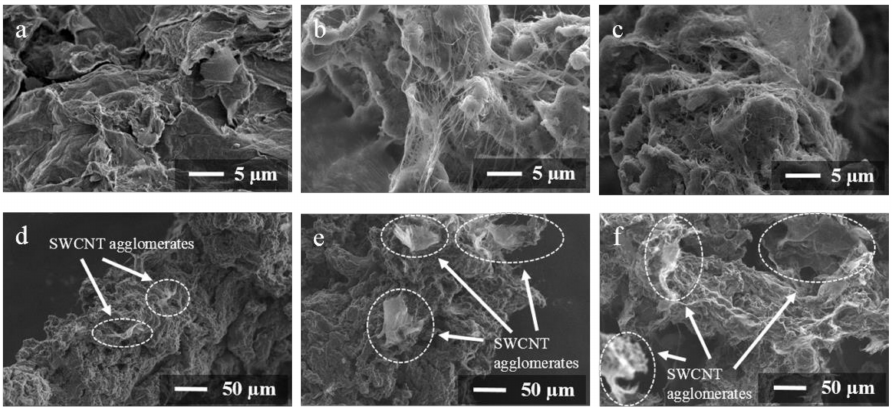
Figure 1. SEM images of the polymer powder particles coated with 1 wt% carbon nanomaterials: ( a ) 1FPC-0, ( b ) 1FPC-50 and ( c ) 1FPC-100. SEM images of the polymer powder particles coated with